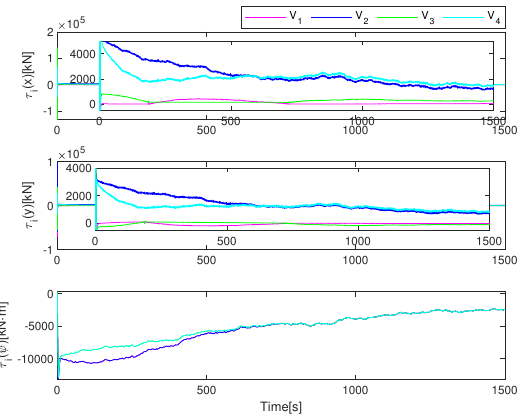
Figure 10. Control inputs of four vessels using proposed control method. ( V i (i = 1,. . . ,4) denotes the i th